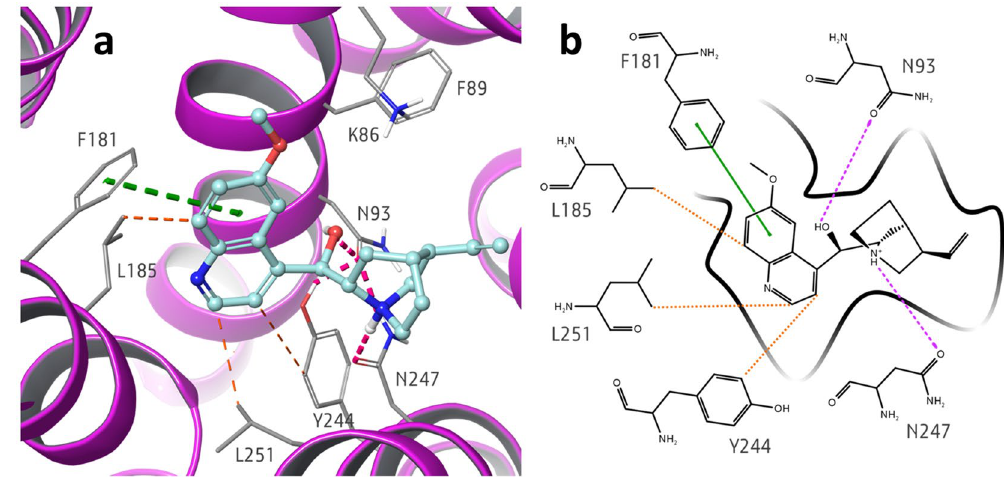
Figure 3. ( a ) 3D and ( b ) 2D representation of the predicted binding mode of quinine at ggTas2r1 receptor. H-bond interactions are shown as magenta dotted lines, π−π interactions as green dashed lines and hydrophobic interactions are represented as the distances between the closest heavy atoms of the ligand and the residue in orange dashed